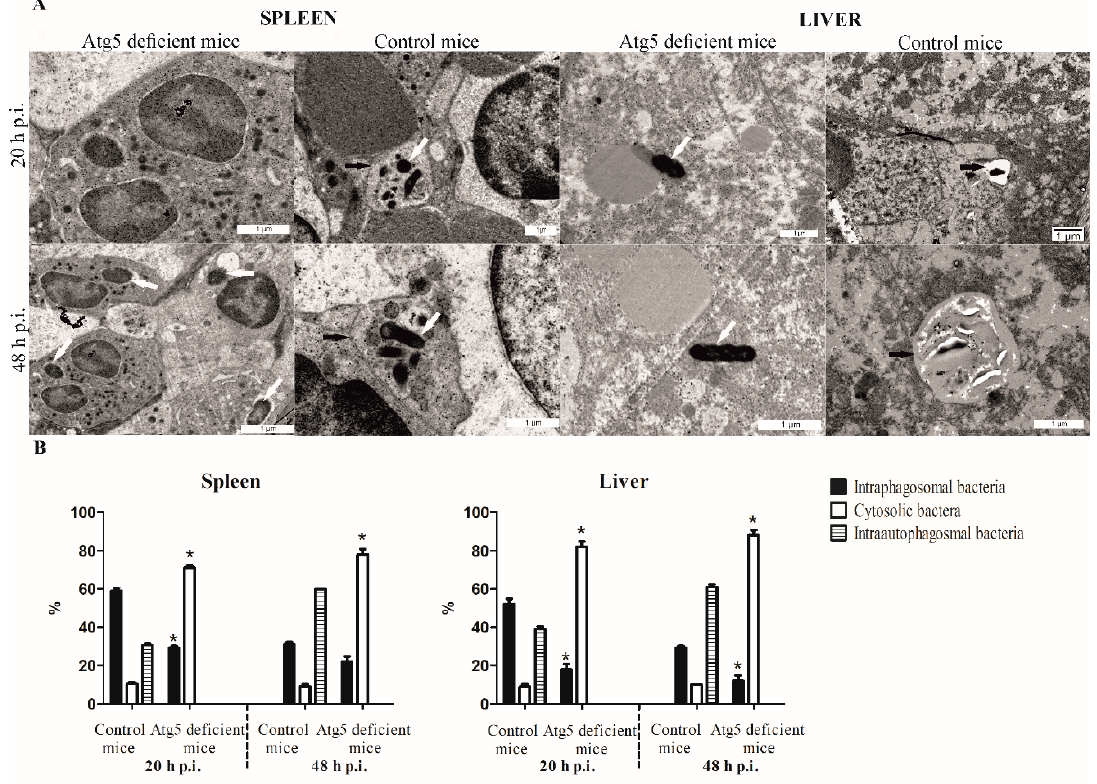
Figure 4. Transmission electron micrographs of spleen and liver tissues of the Atg5-deficient mice and control mice. ( A ) At 20 and 48 h after infection of mice with the LVS, tissues were excised, fixed with glutaraldehyde and processed for electron microscopy. Black arrows show autophagosomal vacuoles and white arrows show bacteria. ( B ) Quantitative analyses of the intact bacteria-containing vacuole. The integrity of the intact vacuoles was determined by electron microscopy counting at least 100 bacteria for each sample using following criteria: cytosolic localization of bacteria, phagosomal localization of bacteria, and autophagosomal localization of bacteria. The error bars represent SD. * p < 0.05 was considered significant in comparison to control mice.